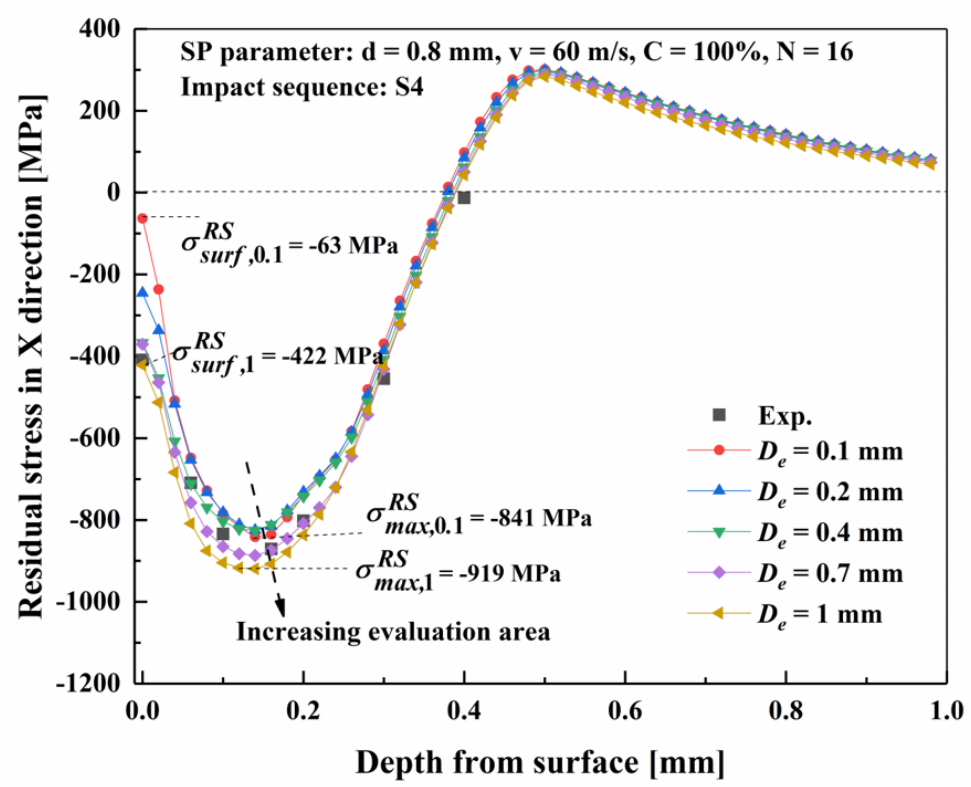
Figure 14. Residual stress depth profile with different evaluation area in order dimple pattern SP model (SP parameter: d = 0.8 mm, V = 60 m/s, C = 100%, N = 16).